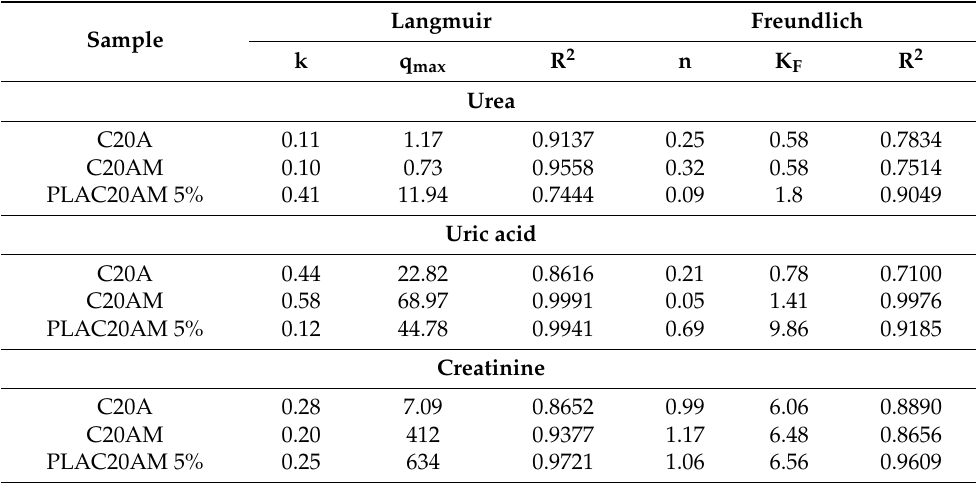
Table 5. Parameters of the isotherm constants and correlation coefficients for the adsorption urea, uric acid and creatinine.